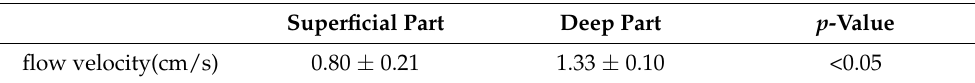
Table 3. Data of flow